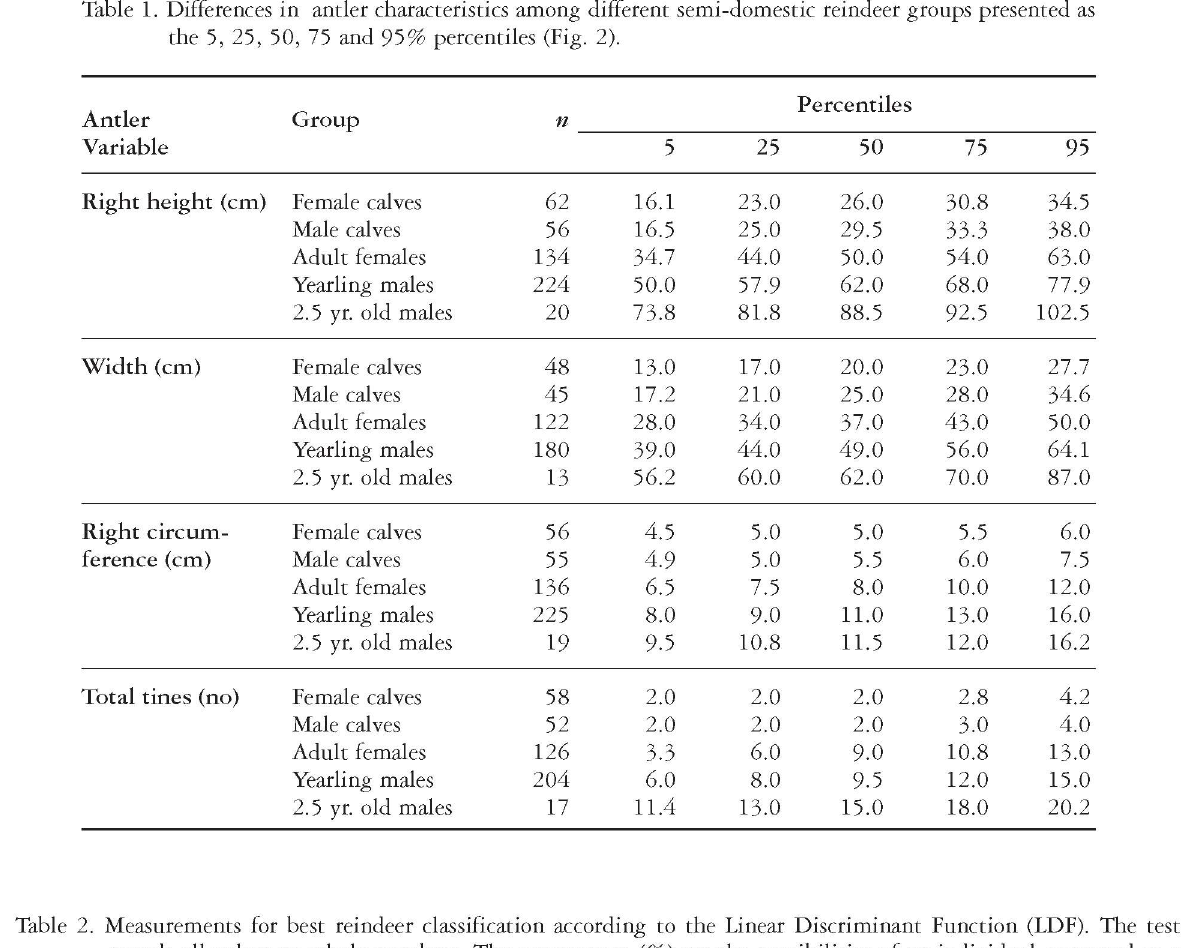
Table 1. Differences in antler characteristics among different semi-domestic reindeer groups presented as the 5, 25, 50, 75 and 95% percentiles (Fig. 2).